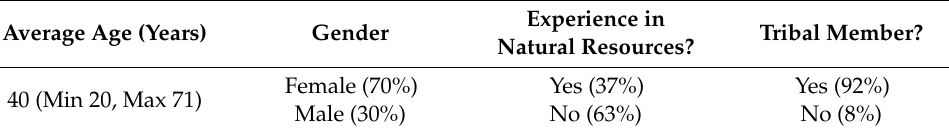
Table 1. Demographic breakdown of interview